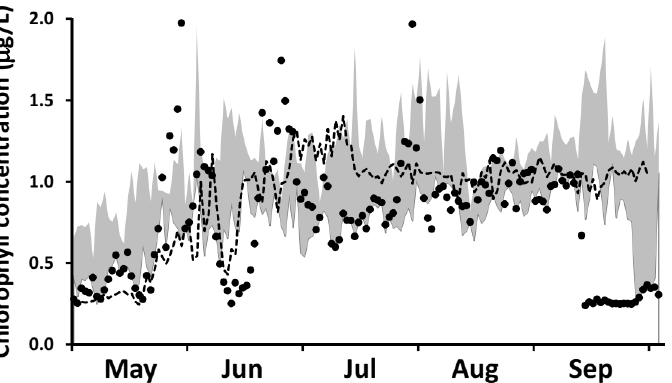
Figure 9. Results of model performance testing for surface water chlorophyll. Circles represent 2016 observed concentrations and the dashed line represents 2016 median modeled concentrations. The gray shaded area represents the 25th and 75th percentiles for daily observations over the (expanded) 2012–2016 interval, included to reflect observed interannual variability.